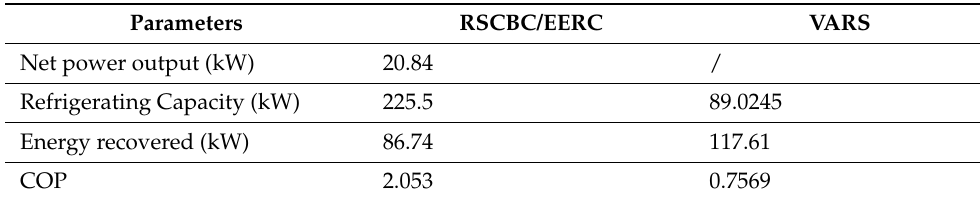
Table 11. The performance parameters of the RSCBC/EERC and absorption refrigeration system. Reprinted from ref. [74], Copyright (2020), with permission from